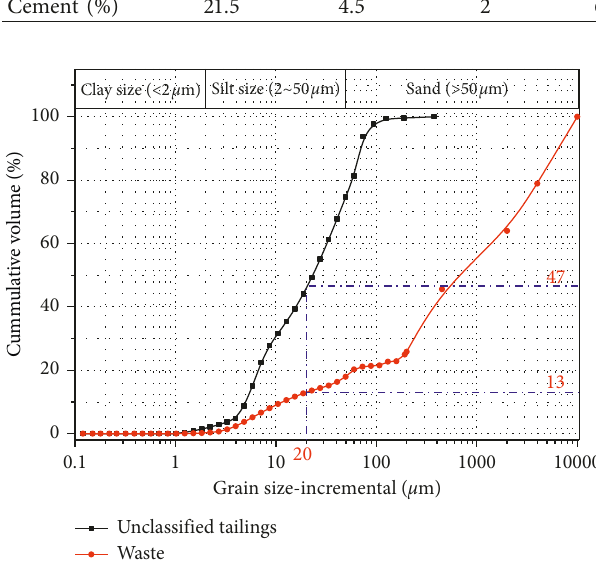
Figure 1: Grain size distribution (GSD) curves of the unclassified tailings compared to a typical range of GSD curves of waste.